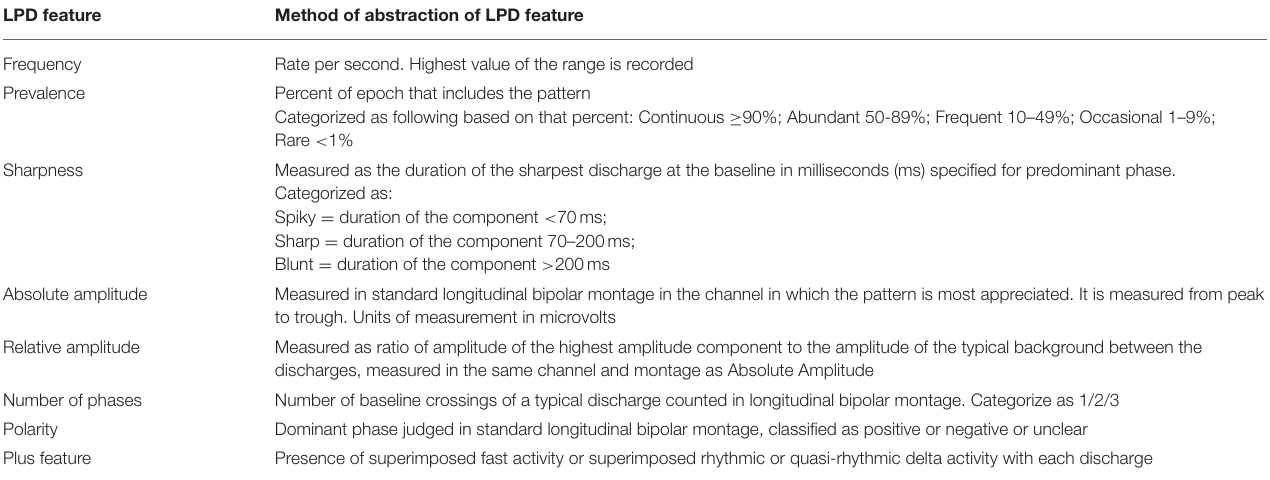
TABLE 1 | Electrographic features of LPDs that were abstracted for each epoch. LPD